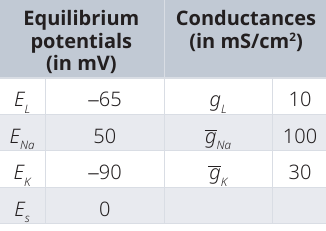
Table 1. Parameter values used in the biophysical